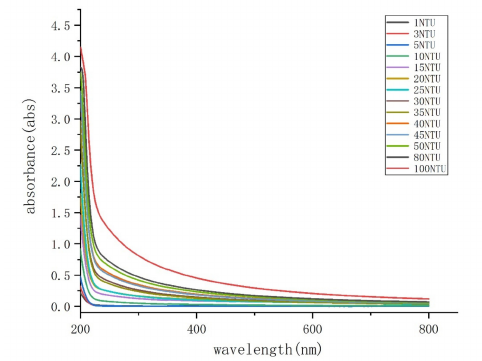
Figure 3. Full spectra of UV–Vis absorbance of turbidity solutions with di ff erent turbidity